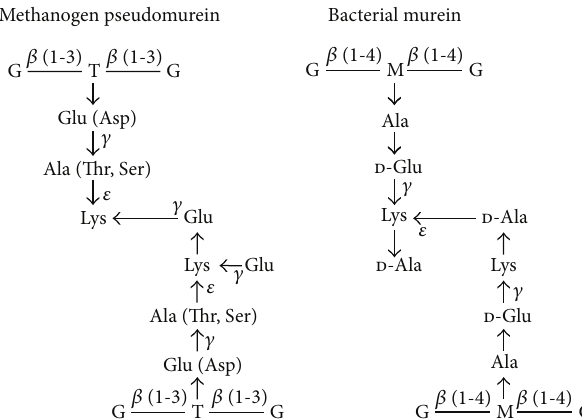
Figure 1: Comparison of the composition of pseudomurein and murein from cell walls. G, N -acetylglucosamine; T, N -acetyltalo- saminuronic acid; M, N -acetylmuramic acid. Methanogen pseu- domurein contains l-amino acids, 𝛽 (1-3) bonds, and N -acetyl- talosaminuronic acid in the glycan chain and several unusual isopeptide bonds. Glu can be replaced by Asp; Ala can be replaced by Thr or Ser, in some strains. Bacterial murein contains d- and l- amino acids and 𝛽 (1-4) bonds and N -acetylmuramic acid in the glycan chain. The figure was adapted and modified from Hartmann and K¨onig [5] and Kandler and K¨onig